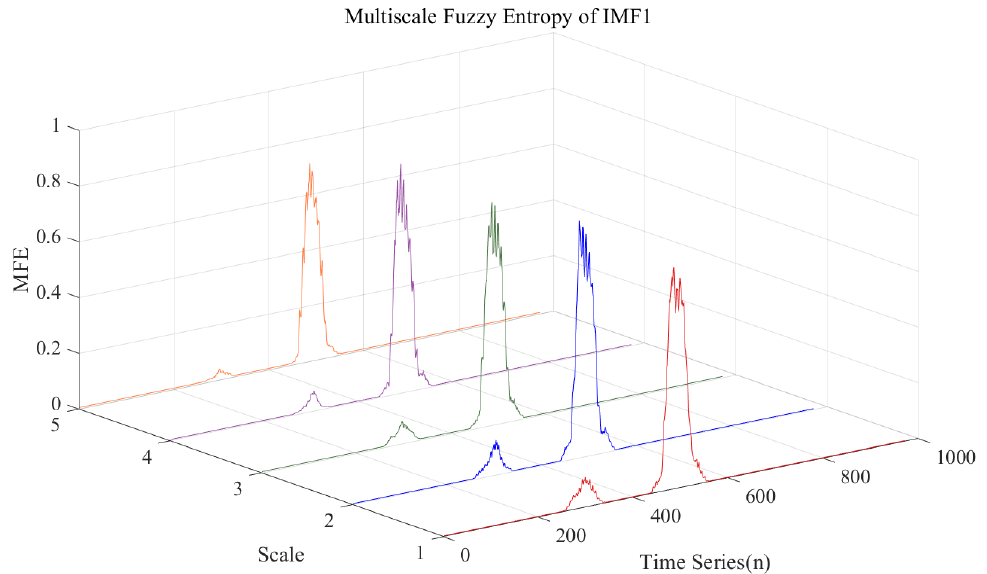
Figure 16. IMFE under different scales of IMF1.